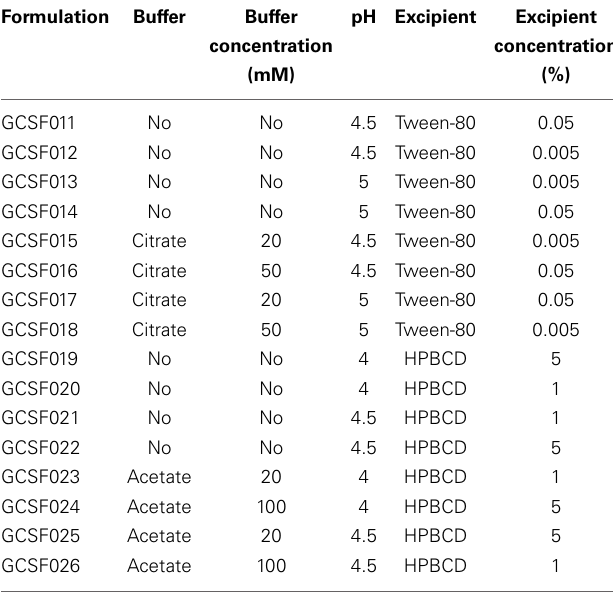
Table 2 | Composition of different formulations containing the protein granulocyte colony stimulating factor (GCSF).